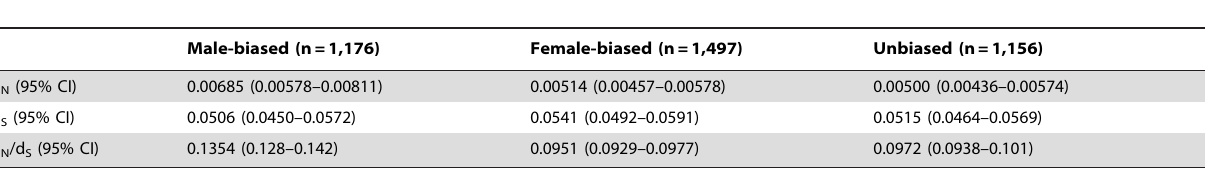
Table 1. Rates of non-synonymous (d N ) and synonymous (d S ) substitution for autosomal sex-biased and unbiased